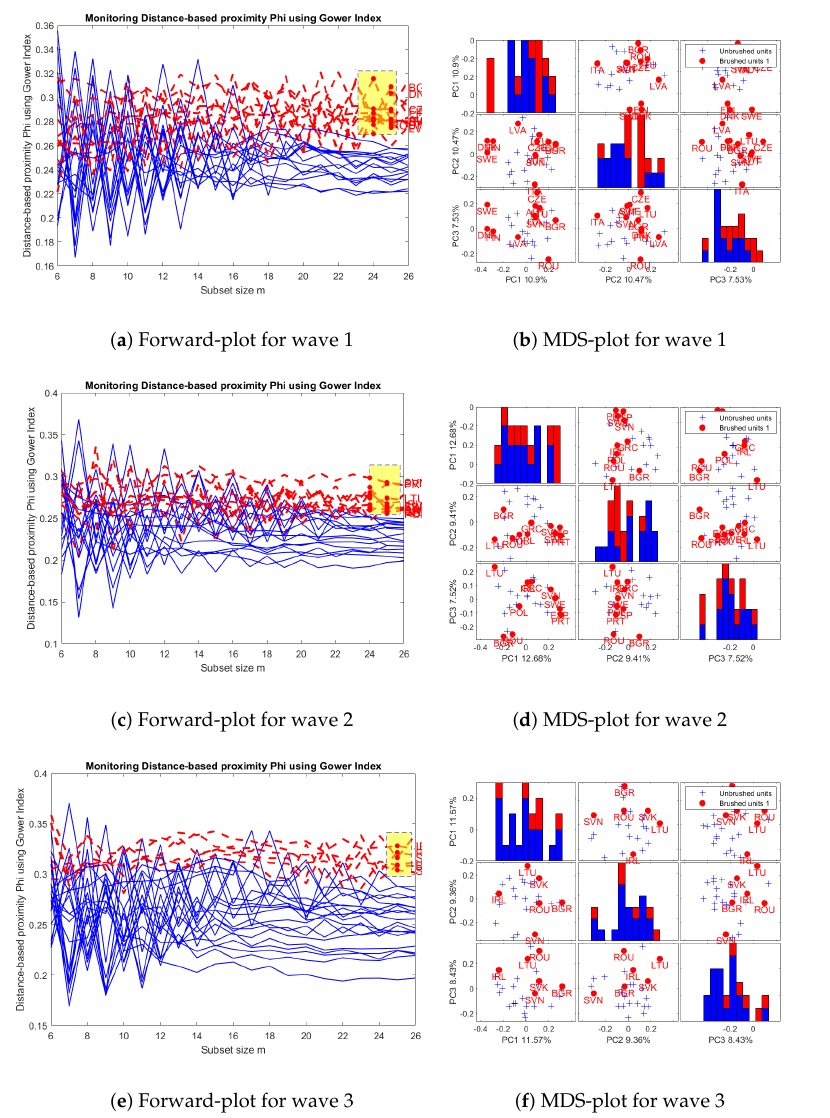
Figure A1. Visualization step: Graphical output of the FS-DB algorithm for waves 1 to 3. Gower’s distance.